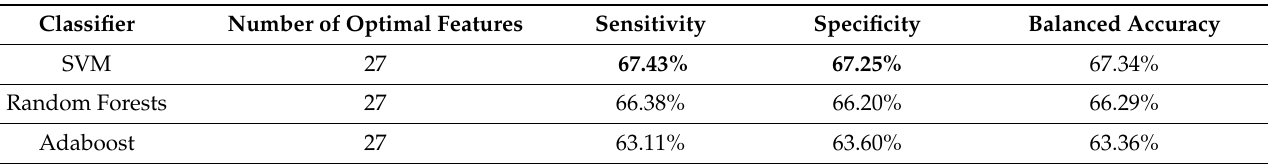
Table 3. Out-of-sample performance measures for the three classifiers (SVM, Adaboost, and Random Forests) using 10-fold CV with 100 iterations on the balanced dataset ( n = 3000